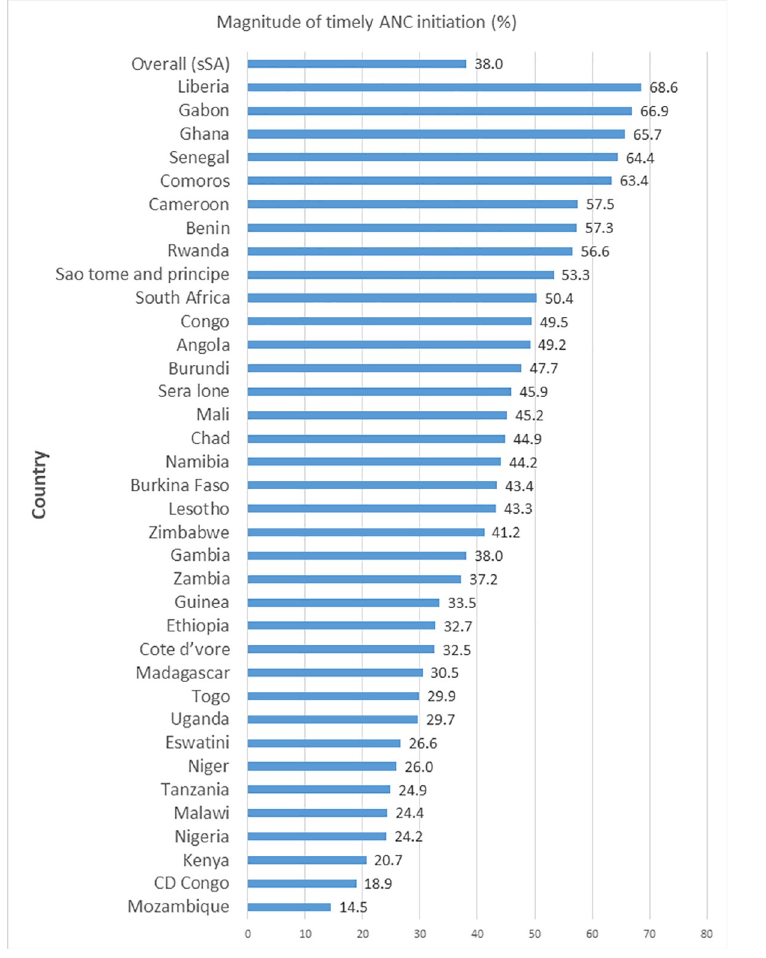
Fig 1. Prevalence of timely initiation of ANC visit in sSA